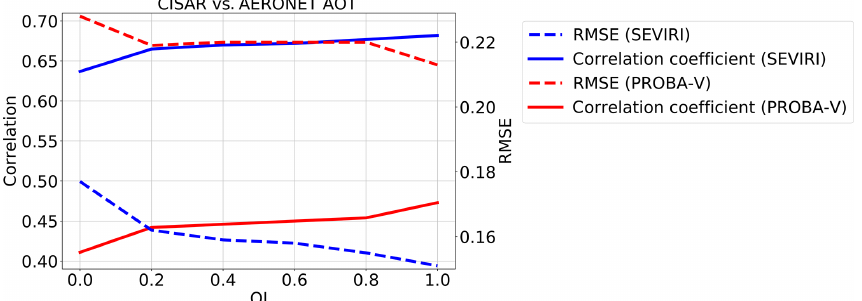
Figure 12. Correlation (straight lines) and RMSE (dashed lines) variations as a function of the QI. The figure refers to the CISAR AOT retrieval from SEVIRI (in blue) and PROBA-V (in red) observations evaluated against AERONET data. The QI is rounded to the nearest 0.1. Table 9. CISAR-retrieved BHR from comparison of actual observations with MODIS in all the processed bands. SEVIRI PROBA-V 0.6µm